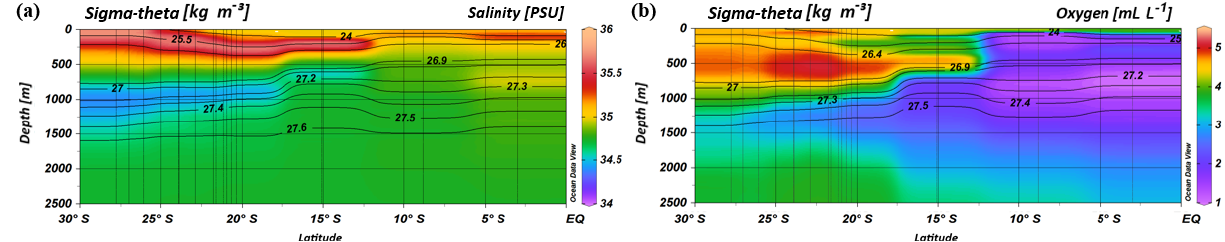
Figure 2. Profiles of salinity (a) and oxygen distribution (b) from CTD measurements during the MSM 59/2 (2016) and SO 259 (2017) cruises. Contour lines indicate the potential density sigma-theta in kilograms per cubic metre (kgm − 3 ).